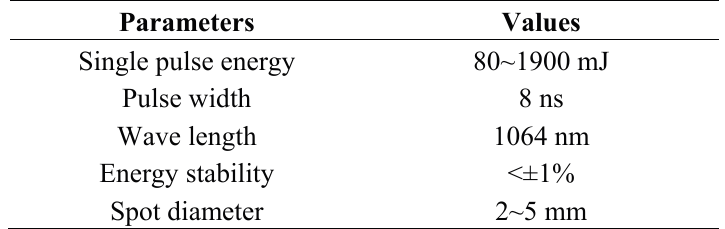
Table 1. Main parameters of Spitlight 2000 Nd-YAG